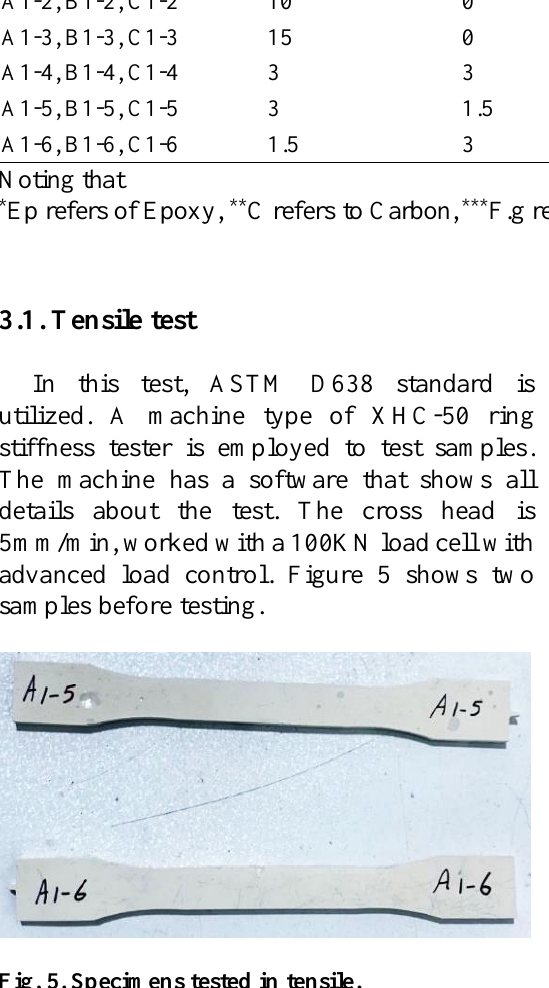
Fig. 5. Specimens tested in tensile.